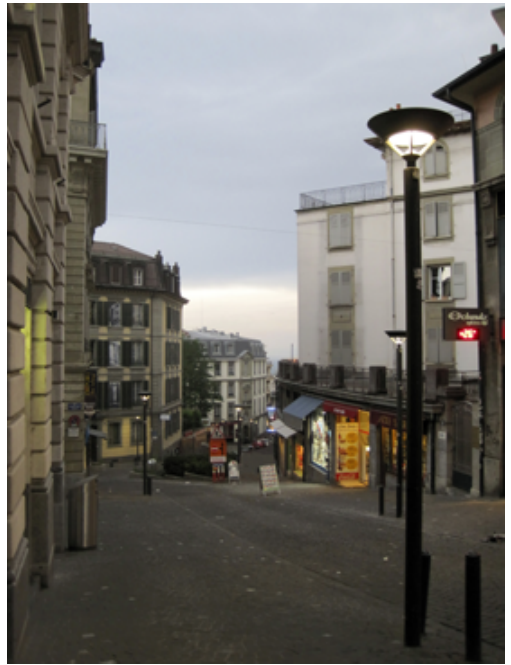
Figure 5. Urban environment without people (Study 2).